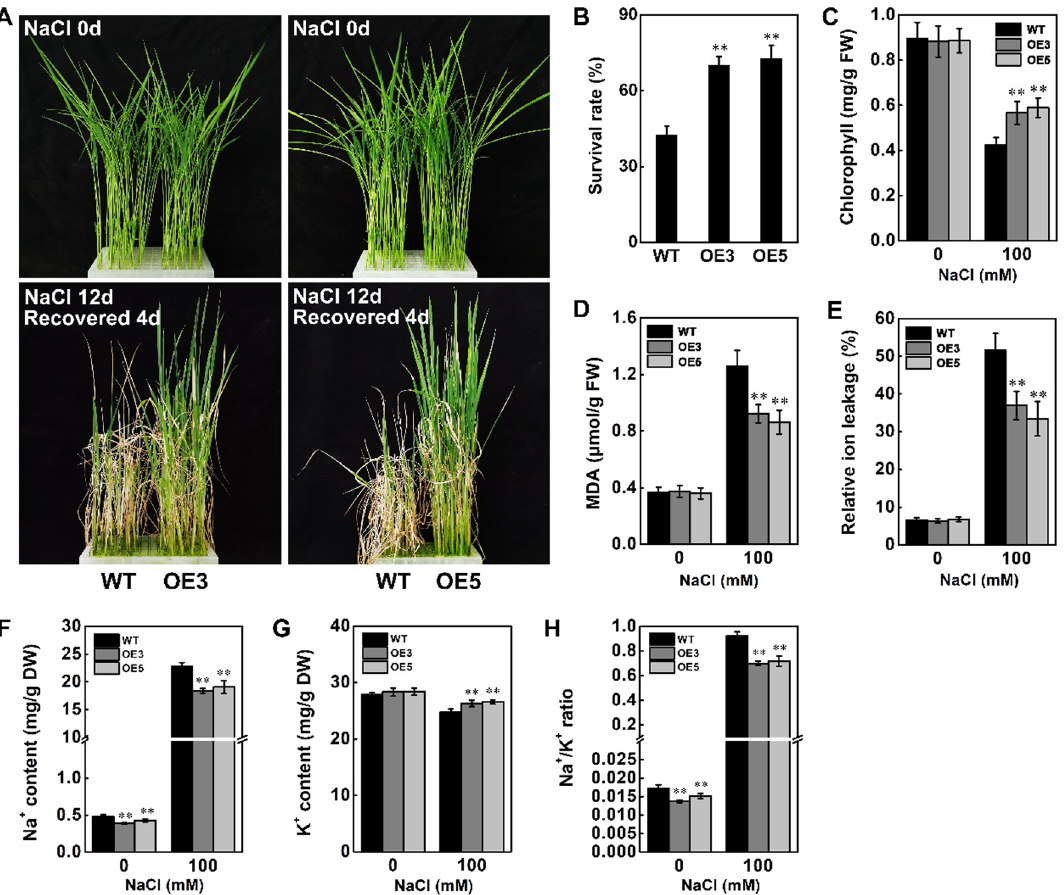
Fig. 3 Overexpression of STK increased salt tolerance in rice. A Phenotype of WT, OE3 and OE5 rice plants under salt stress at seedling stage. For STK -OE transgenic plants, 15-d-old seedlings were treated with 140 mM NaCl for 12 d and recovery 4 d. B Survival rates of WT and transgenic plants in (A) after 4 d of recovery. C Chlorophyll content in leaves of 15-d-old plants treated with 100 mM NaCl for 7 d. D MDA concentrations in leaves of 15-d-old plants after 100 mM NaCl treatment for 24 h. E Relative ion leakage in leaves of 15-d-old plants after 100 mM NaCl treatment for 24 h. F–H Ion content in shoots of 4-week-old plants after 6 d of salt stress (100 mM NaCl). Wild type and STK -OE plants were exposed to salt stress (100 mM NaCl) for 6 d and the shoots were harvested for analysis of ion content. The Na + and K. + contents in seedlings were detected as previously described (Schmidt et al. 2013). Data in B – H are presented as mean SD (n 3, ** P 0.01, Tukey’s ± = ≤